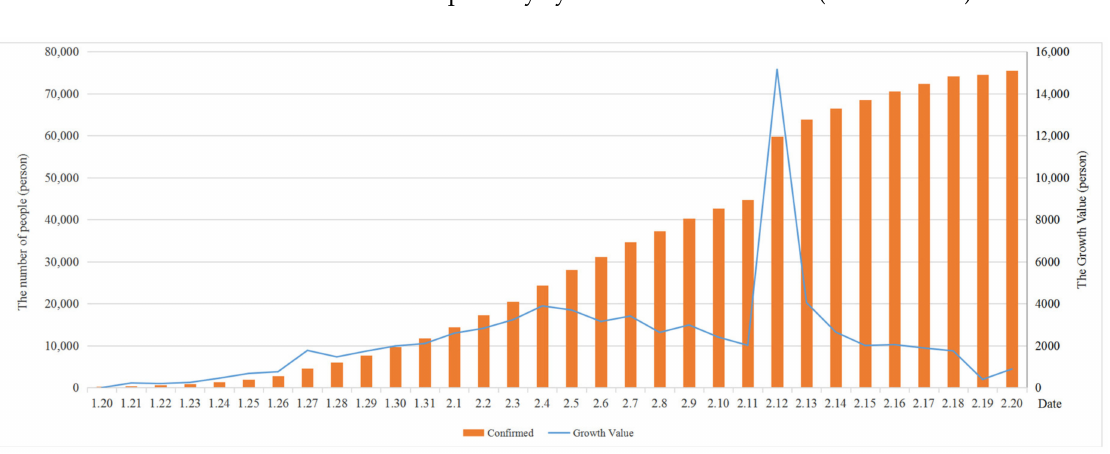
Figure 1. Changes in the numbers of confirmed and newly confirmed cases in China from 20 January to 20 February.